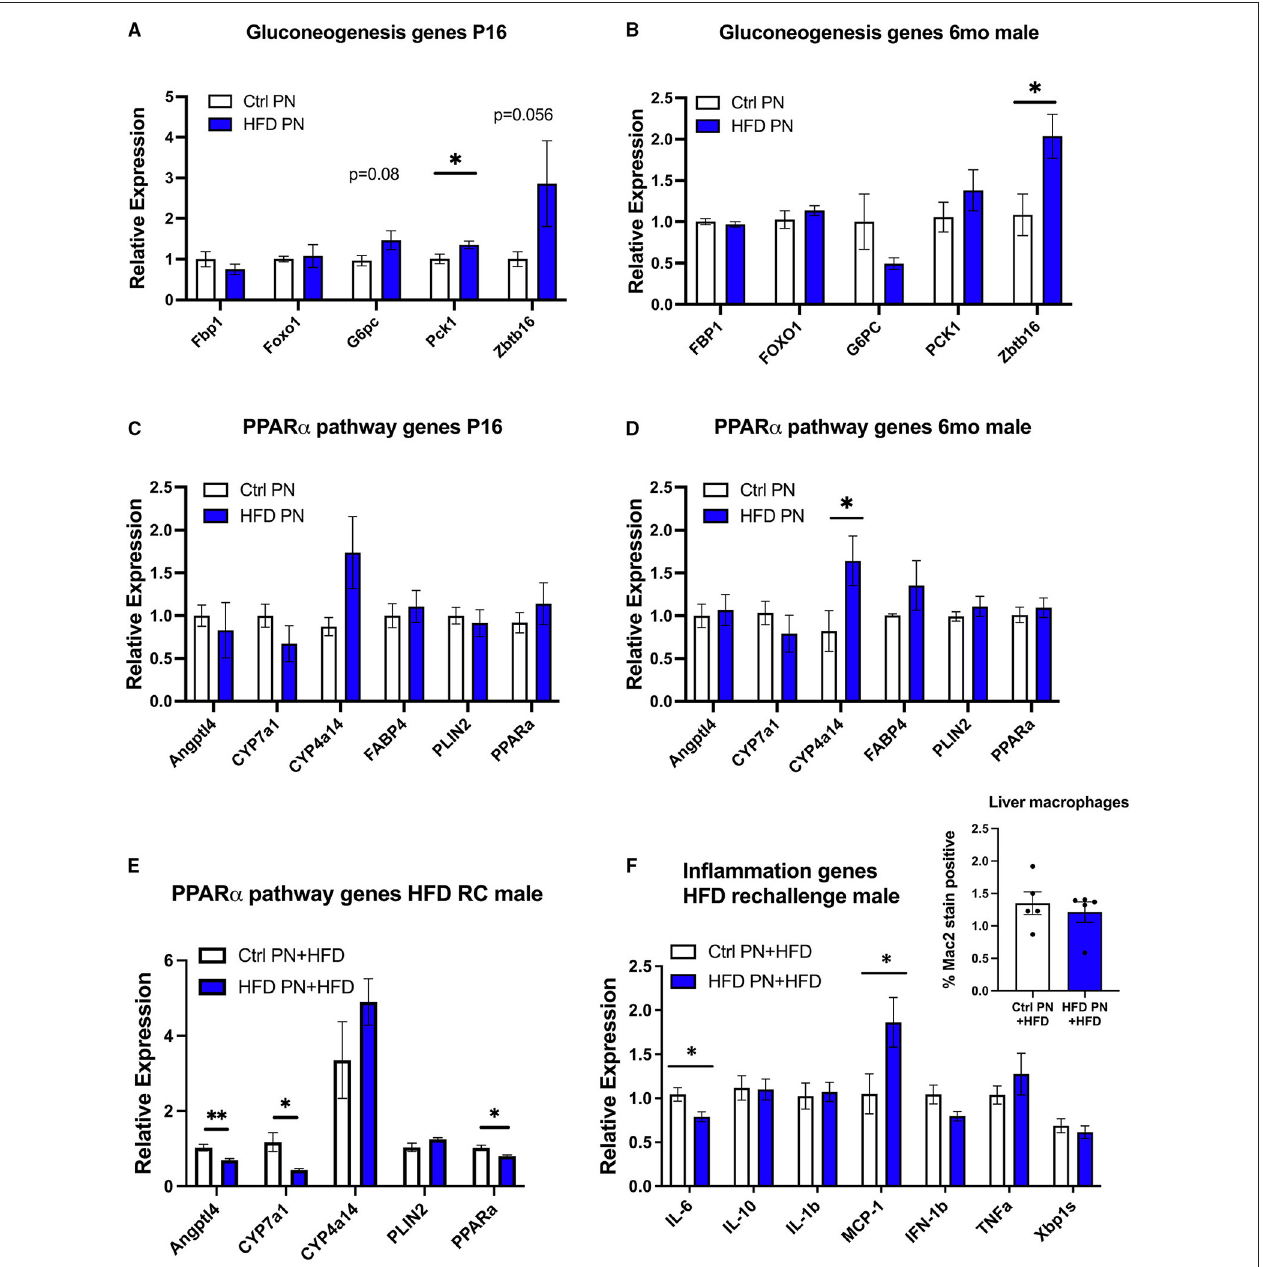
FIGURE 5 | Offspring hepatic gene expression across the lifespan. Gene expression data are representative of individual mice and not averaged per litter. White values are for Ctrl PN, and blue are for HFD PN offspring. Gluconeogenesis genes at post-natal day 16 (P16) Ctrl PN n = 9–10, HFD PN n = 4–7 per gene (A) and in adult male offspring maintained on ND at 6-month Ctrl PN n = 4–5, HFD PN = 4–5 per gene (B) . PPAR-alpha pathway genes at P16 Ctrl PN n = 9–12, HFD PN n = 10–13 per gene (C) , and in adult male offspring maintained on ND at 6-month Ctrl PN n = 7–8, HFD PN n = 7–9 per gene (D,E) . PPAR-alpha pathway genes in male offspring rechallenged with HFD at 6-months Ctrl PN + HFD n = 8, HFD PN + HFD n = 8 per gene (F) . Inflammatory genes in male offspring rechallenged with HFD at 6-months Ctrl PN + HFD n = 6–8, HFD PN + HFD n = 8 per gene with quantitation of liver macrophages in HFD rechallenged males at 6 months using immunofluorescent staining for Mac2 (inset). Ctrl, control; HFD, high-fat diet; PN, post-natal. * p < 0.05, ** p < 0.01.